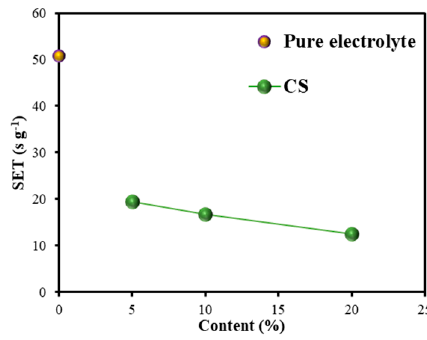
Figure 6. SET test using and CS and pure electrolyte.